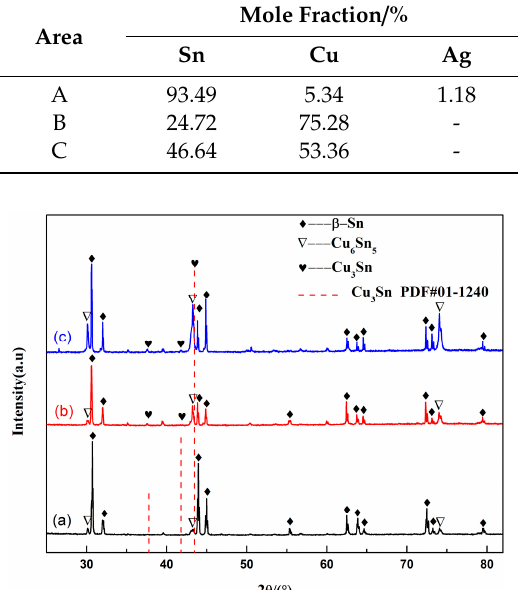
Figure 14. XRD analysis results of the fracture surface aged at 175 °C with different aging times: ( a ) 0 h, ( b ) 192 h, and ( c ) 360 h.